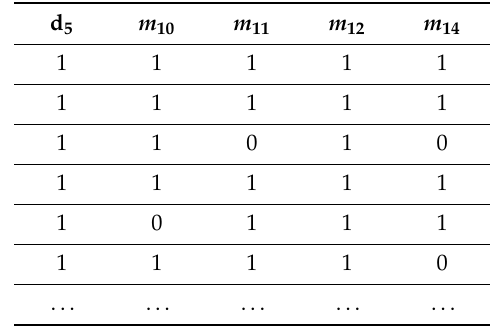
Table 4. Failure anomaly